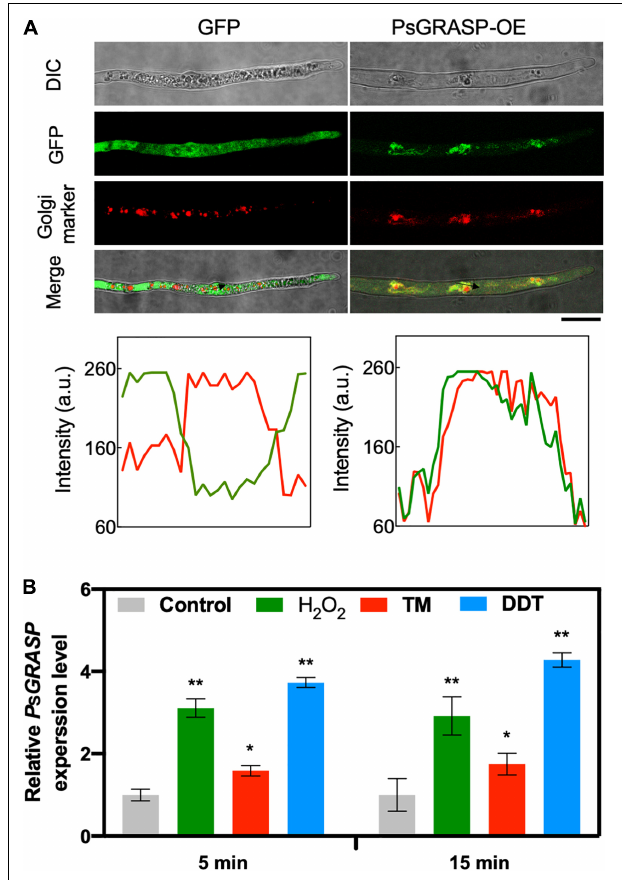
FIGURE 4 | PsGRASP is localized to Golgi apparatus. (A) From top to bottom: co-localization of PsGRASP-OE (PsGRASP fused with a GFP tag) and Golgi-Tracker Red marker in P. sojae . Images of differential interference contrast (DIC), GFP, and red fluorescence derived from the Golgi-Track Red dye. Merge overlay of DIC, GFP fluorescence, and Golgi-Track Red dye staining. Bar, 20 µ m. Relative fluorescence intensity along with the block arrows in (A) . Lines and graph analysis of the co-localization patterns. Green line: GFP or PsGRASP-OE. Red line: Golgi (stained with the Golgi-Track Red dye). (B) Expression profiles of PsGRASP under different stress conditions. The wild-type mycelium was subject to treatments with control (H 2 O), H 2 O 2 , TM or DTT. The control value (1.0) was set as a reference. Results represent mean values ± SD from three independent experiments. * P < 0.05, ** P < 0.01, Student’s t